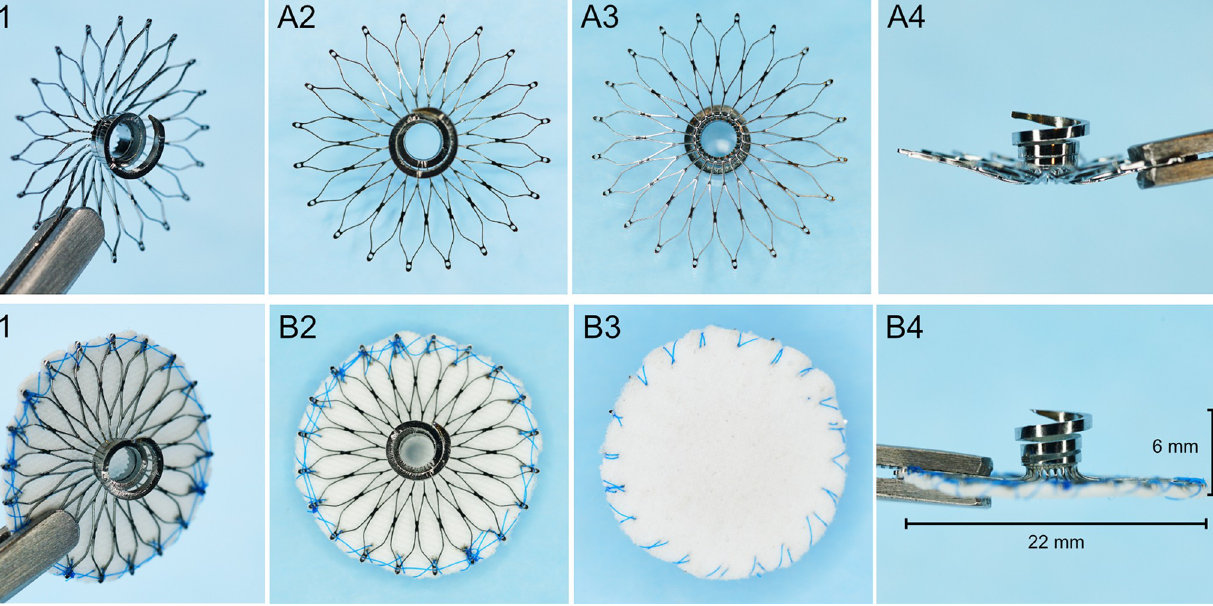
Fig 1. StrokeShield device. The two primary components of the StrokeShield device (22 mm width, 6 mm height) include conical anchor which screws into the LAA myocardium to secure the device, and a Dacron-covered Nitinol umbrella membrane that unfolds following deployment to occlude and collapse the LAA. The upper (A1-A4) and lower (B1 = B4) photos show device with bare Nitinol wire and Dacron-covered umbrella frame, respectively, for isometric (A1,B1), front (A2,B2), back (A3,B3), and side (A4,B4)